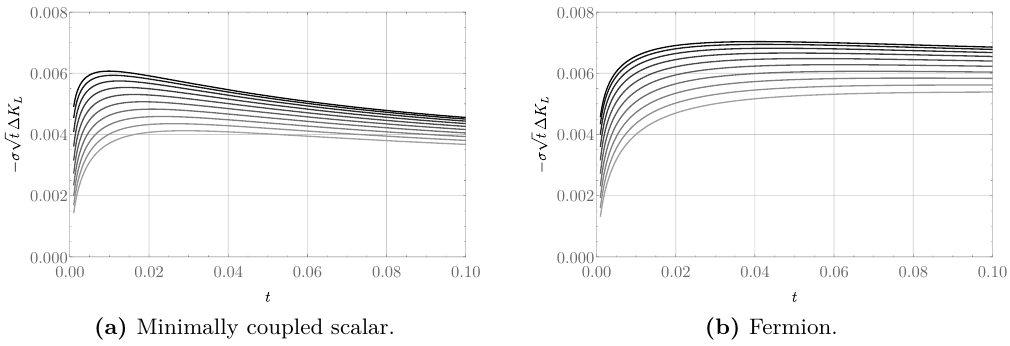
√ t . At small-but-not-too-small t , ∆ K L